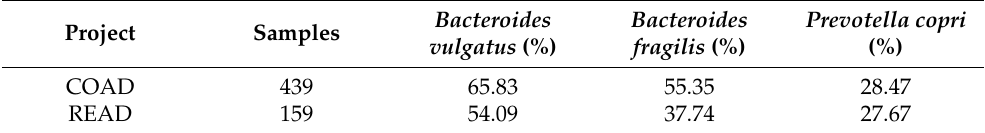
Figure 3. α -GalCer-producing bacteria infiltrate colon and rectum adenocarcinoma tissues. The distri- bution of the relative abundance of Bacteroides fragilis , Bacteroides vulgatus , and Prevotella copri in colon adenocarcinoma (COAD) and rectum adenocarcinoma (READ) tissues was calculated from TCMA. Table 2. Infiltration of α -GalCer-producing bacteria in colorectal adenocarcinoma. The TCMA relative abundance data were used to calculate the presence or absence of the bacteria in colon adenocarcinoma (COAD) and rectum adenocarcinoma (READ) tissues. A bacterium is classified as present if the sample has a rel. abundance value > 0 and as absent if the rel. abundance value =